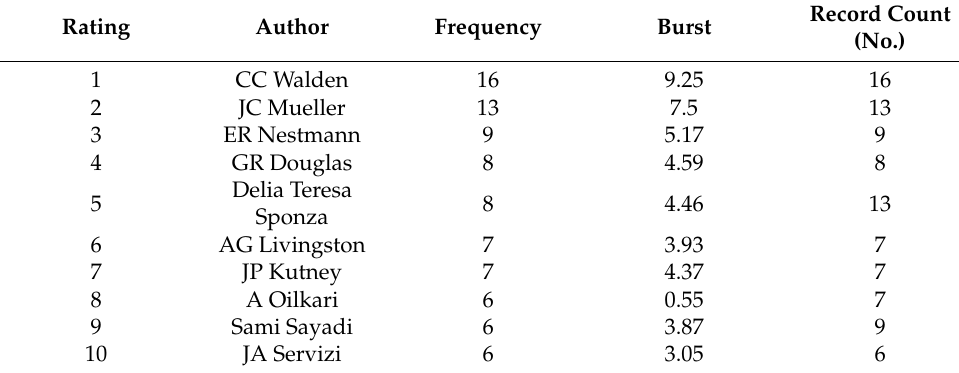
Figure 6. The analysis regarding the authors who have contributed to the field of industrial effluent and sludge toxicity during the adopted period achieved from the utilization of CiteSpace software. Table 3. The characteristics (frequency, burst, and record count) of the authors contribute to industrial effluent and sludge toxicity based on the achieved documents during the adopted duration from 1950 to 2020 obtained from CiteSpace. Accordingly, the number of documents published by each of the authors in this field and during this period has been gathered from WoS analysis. They are represented as “record counts”.